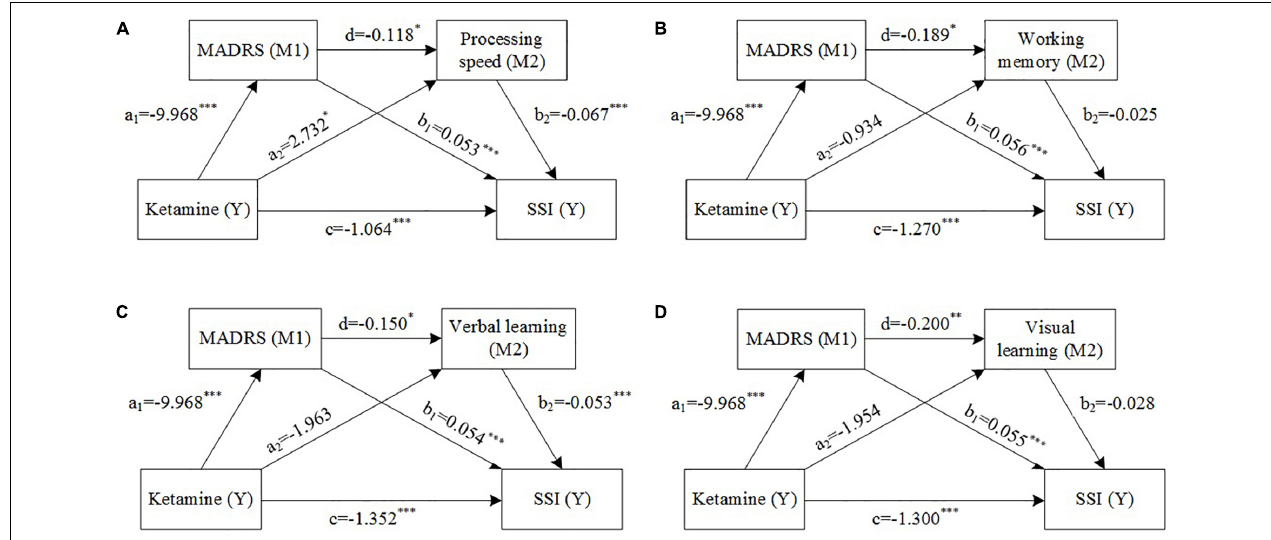
FIGURE 2 | Mediation models with depressive symptom severity (M1) and cognition [M2, (A) processing speed, (B) working memory, (C) visual learning, (D) verbal learning] as mediators between ketamine treatment and suicide ideation. Estimated path coefficients are referred to (A–D) . ∗ P < 0.05, ∗∗ P < 0.01, ∗∗∗ P <